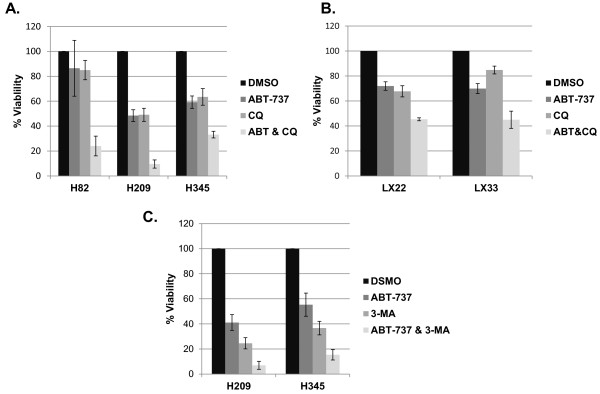
Combination treatment of ABT-737 with autophagy inhibitors results in decreased proliferation in SCLC cell lines. Cells were plated in 96-well plates and treated with DMSO, ABT-737, chloroquine (CQ), and the combination of ABT-737 and chloroquine. At 72 hours post-treatment they were assayed using the MTS cell proliferation assay. Commercially available cell lines are shown in A and cell lines derived from low passage cultures of primary patient xenografts in B. Doses chosen were based on initial determination of IC50 values and were as follows: H82 (17 μM ABT-737, 16.5 μM chloroquine), H209 (0.5 μM ABT-737, 20 μM chloroquine), H345 (0.25 μM ABT-737, 94 μM chloroquine), LX22 (6 μM ABT-737, 40 μM chloroquine), and LX33 (0.8 μM ABT-737, 33 μM chloroquine). C. Similar treatments were performed combining ABT-737 and 3-methyladenine, another autophagy inhibitor. 3-methyladenine doses were 5 mM for both lines. Error bars: standard deviation (SD); n = 4.